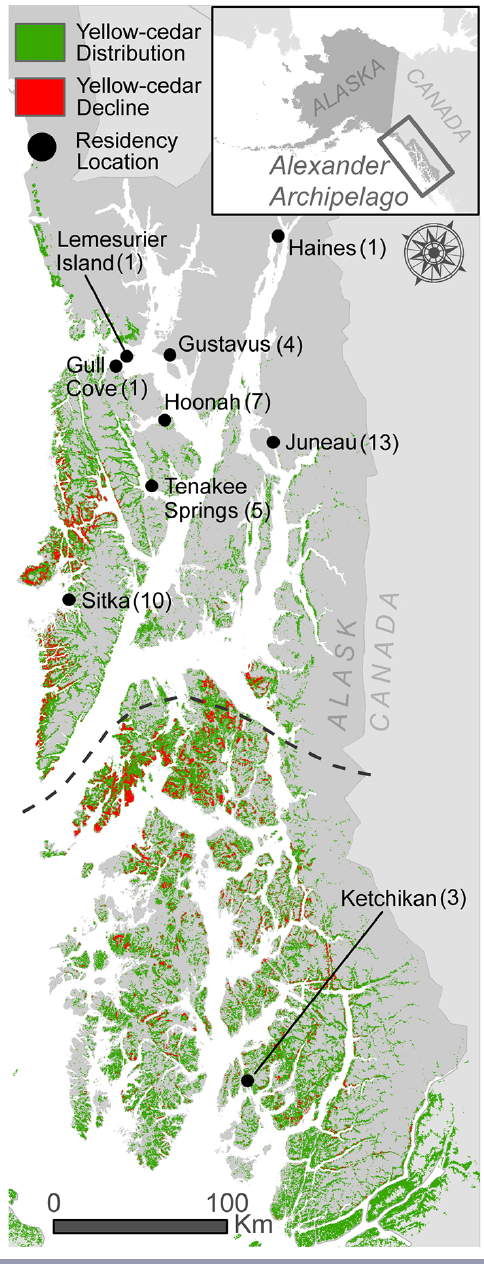
Fig. 1 . Residency locations in southeast Alaska for study participants (n) with yellow-cedar decline (USDA-FS 2010) and distribution (Hennon et al. 2015). Dashed line indicates current northern limit of western red cedar